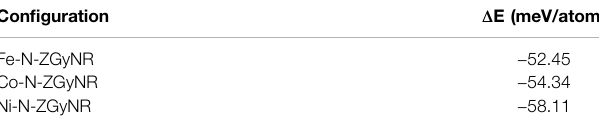
TABLE 1 | The formation energies of M-N-ZGyNR.